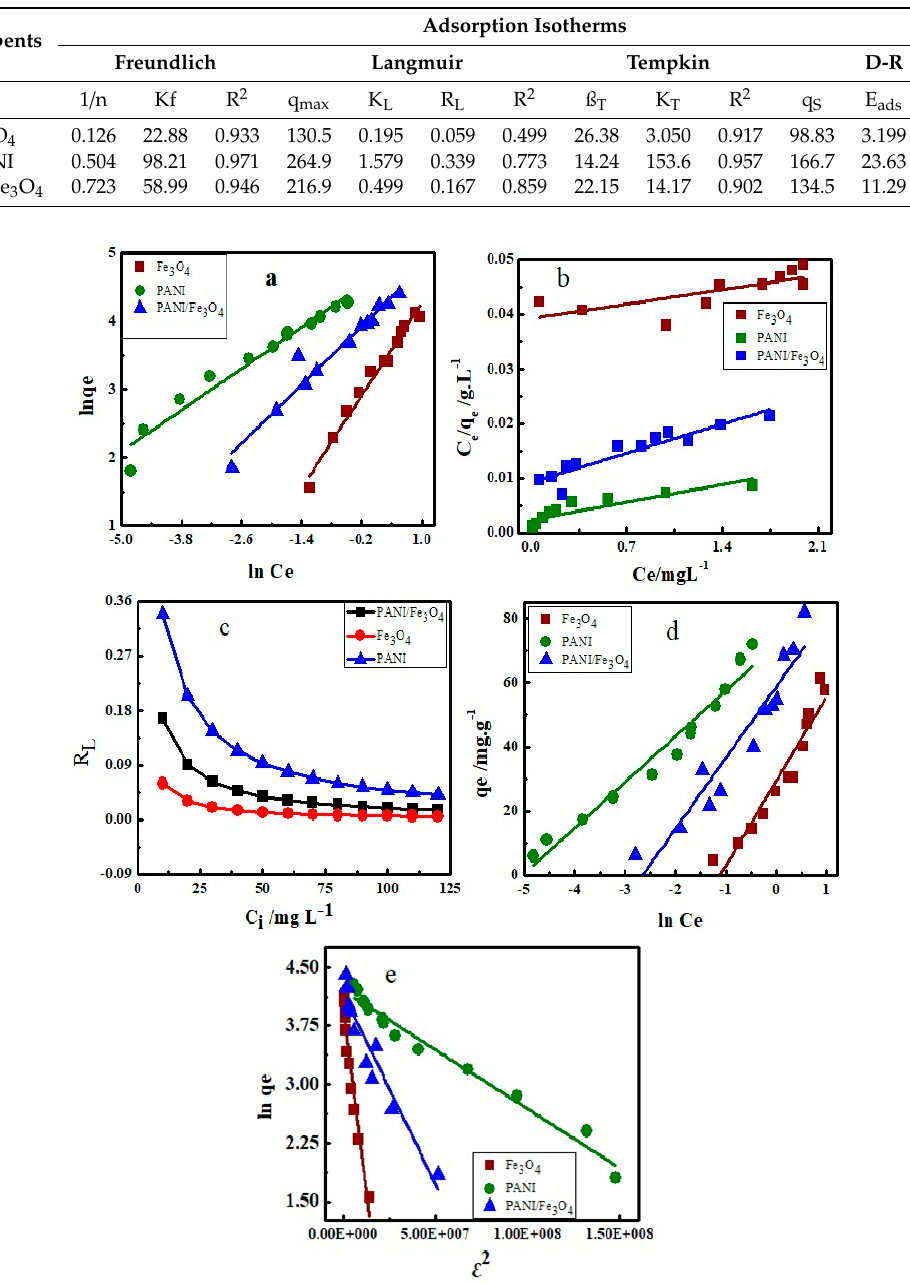
Figure 6. The Isotherm plots ( a ) Freundlich, ( b ) Langmuir, ( c ) Separation factor, ( d ) Tempkin and ( e ) D–R of adsorption of AB40 on Fe 3 O 4 , PANI and PANI/Fe 3 O 4